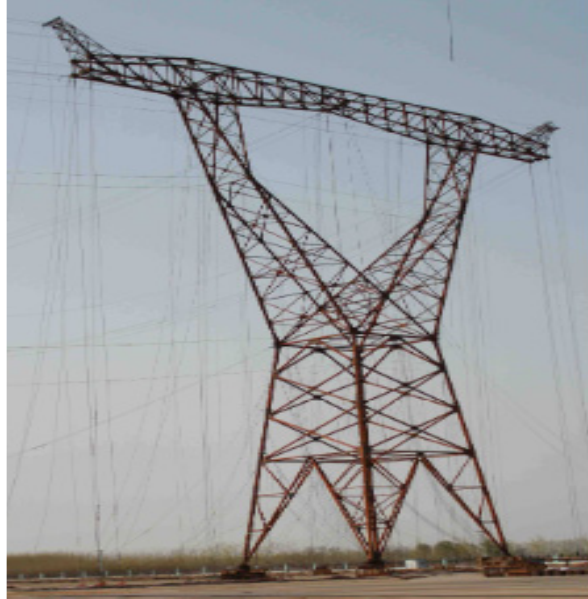
Figure 26. Full ‐ scale testing the ZB1 cup ‐ type tower [81]. Figure 26. Full-scale testing the ZB1 cup-type tower [81].